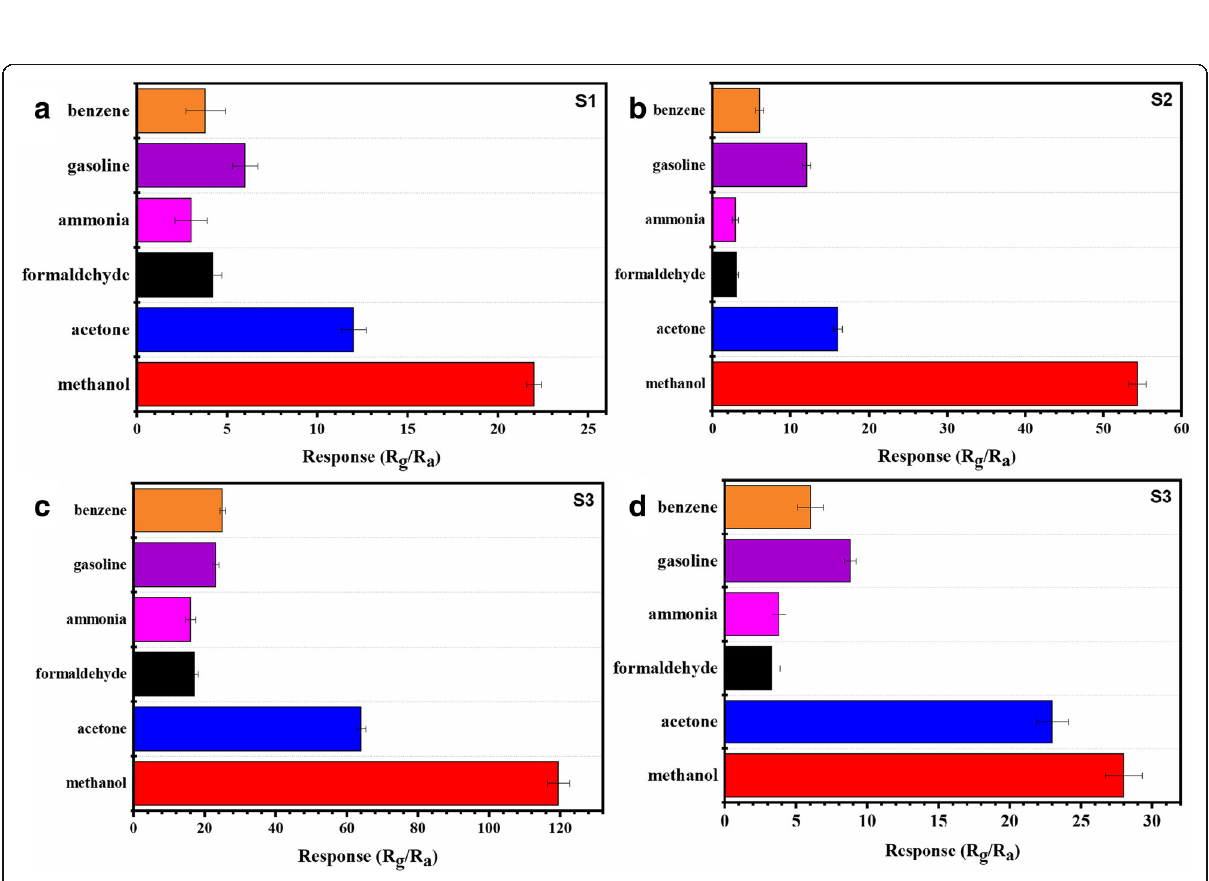
Fig. 8 Selectivity of microsphere at different hydrothermal time based on S1 ( a ), S2 ( b ), S3 ( c ), and S4 ( d ) to various gases with a concentration of 5 ppm at 195